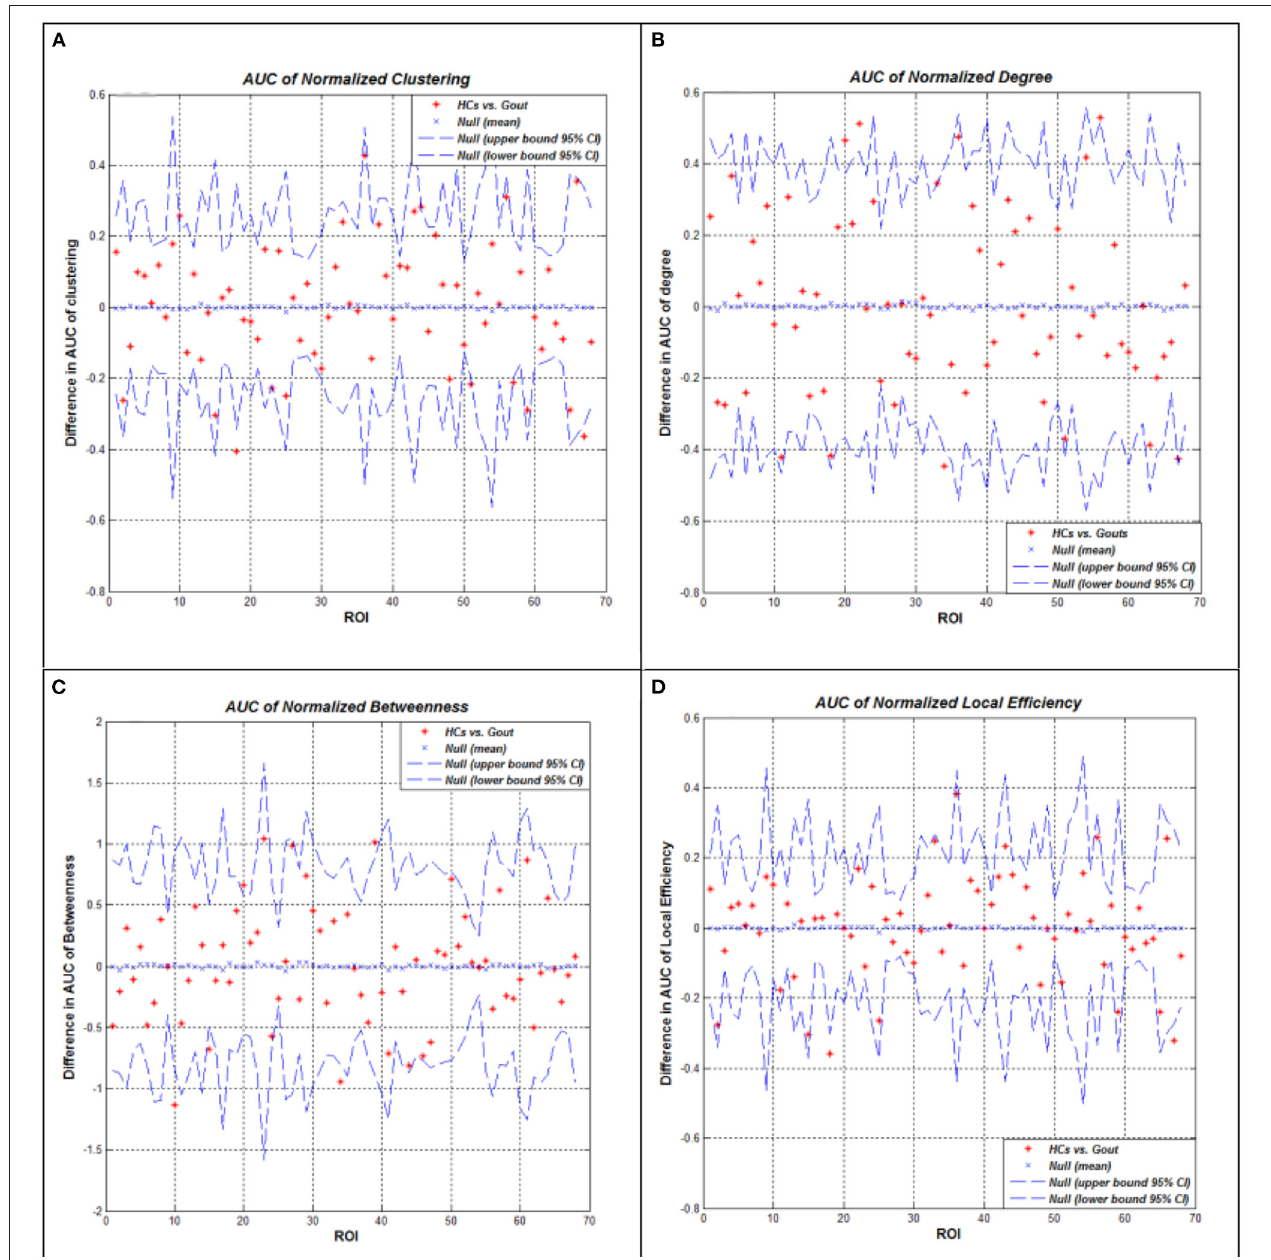
FIGURE 4 | Between-group differences of measures across a range of network densities: normalized clustering coefficient (A) , degree (B) , betweenness (C) , and local efficiency (D) . The red * lying outside of the confidence intervals indicates regions in which the difference between the two groups in this density is significant. All regions survived following FDR correction ( p < 0.05). Gout, gout group; HCs, healthy controls; AUC, area under the curve; FDR, false discovery rate.